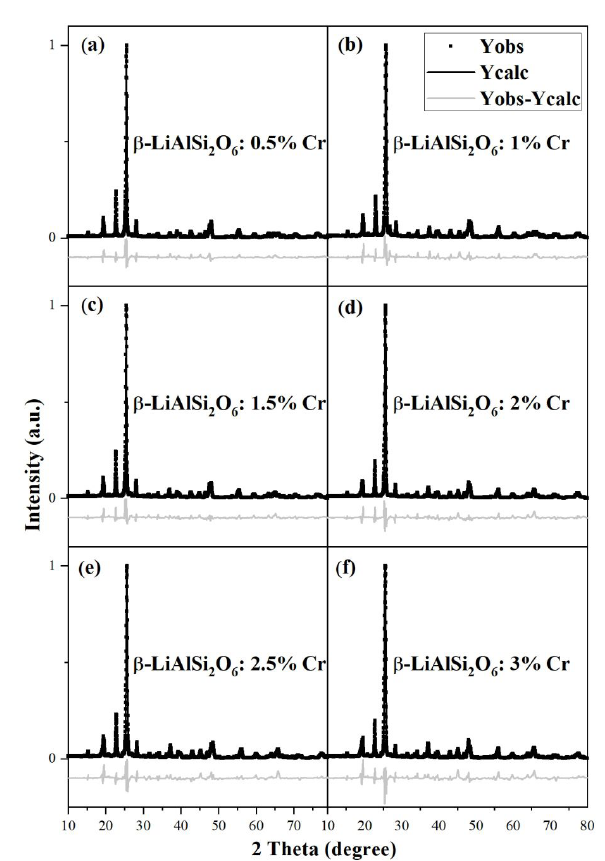
O :Cr and Y(calc) spectra calculated by Rietveld method. 2 6